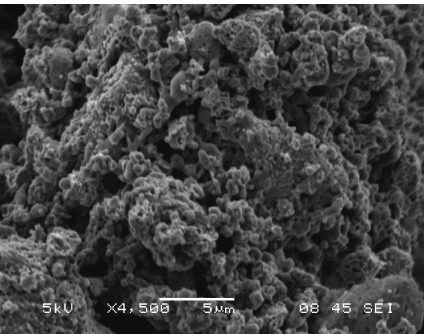
Figure 2: A representative SEM image of the as-synthesized LiFePO 4 /C powders.